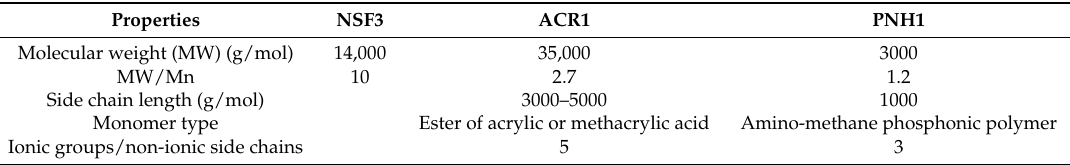
Table 2. Main properties of naphthalene, polycarboxylate-and the experimental phoshonate-based